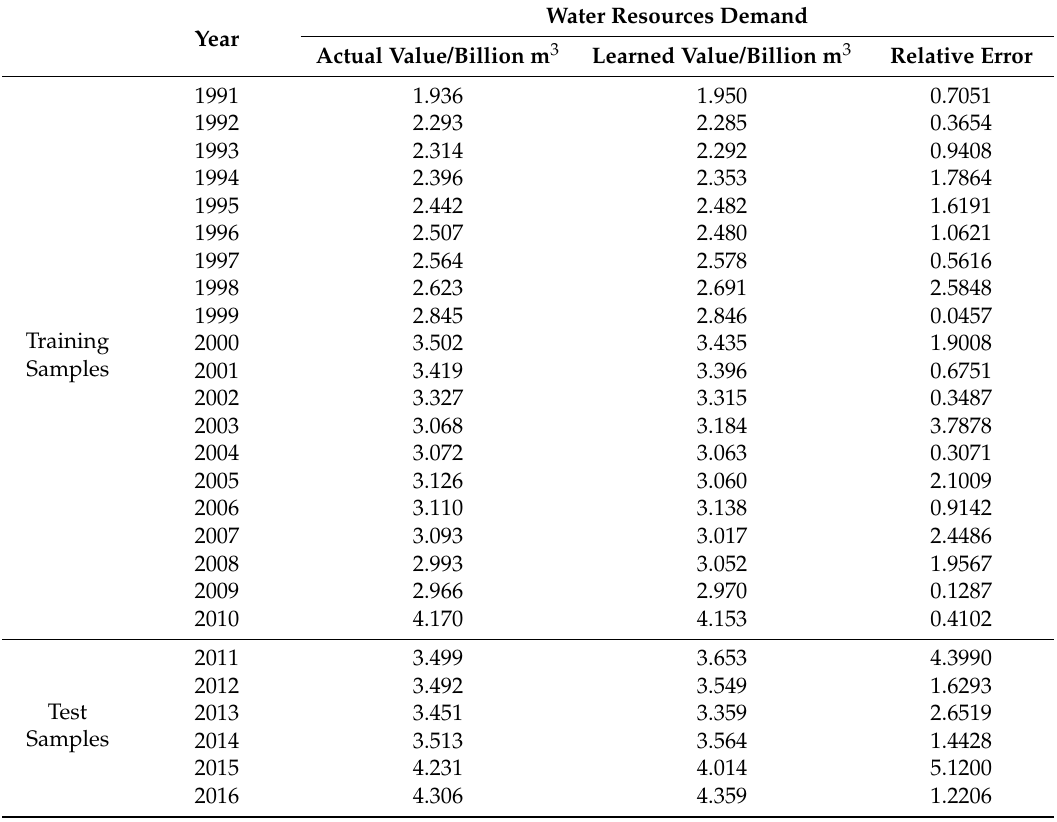
Table A1. Training and test data for water resources demand in Wuxi.